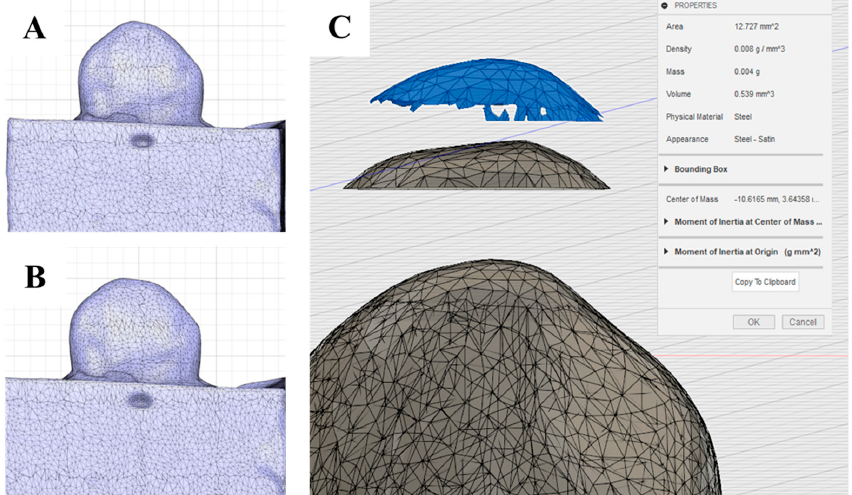
Figure 3. Measuring volumetric loss of ceramic specimens using three-dimensional images: ( A ) STL file of the ceramic specimen before wear testing. ( B ) STL file after wear testing. ( C ) Wear volume measurement; wear volume (blue part; top) = STL file before wear (bottom)-STL file after wear (middle).